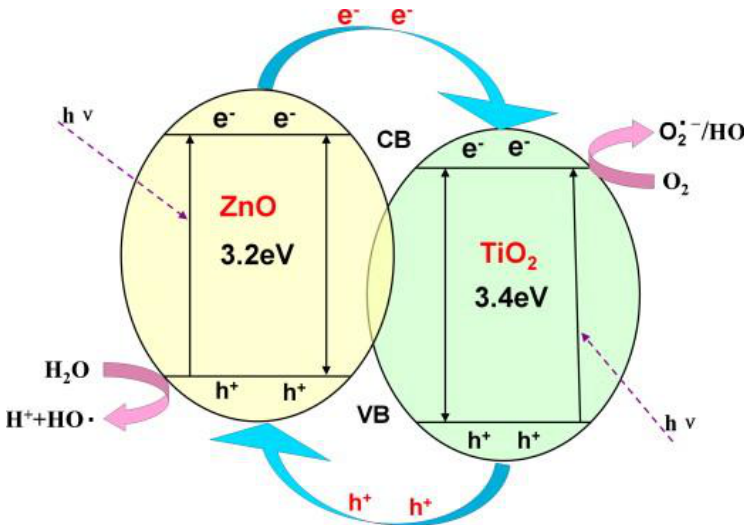
Figure 11. The mechanism of charge separation and photocatalytic activity of the TiO /ZnO nanofibers 2